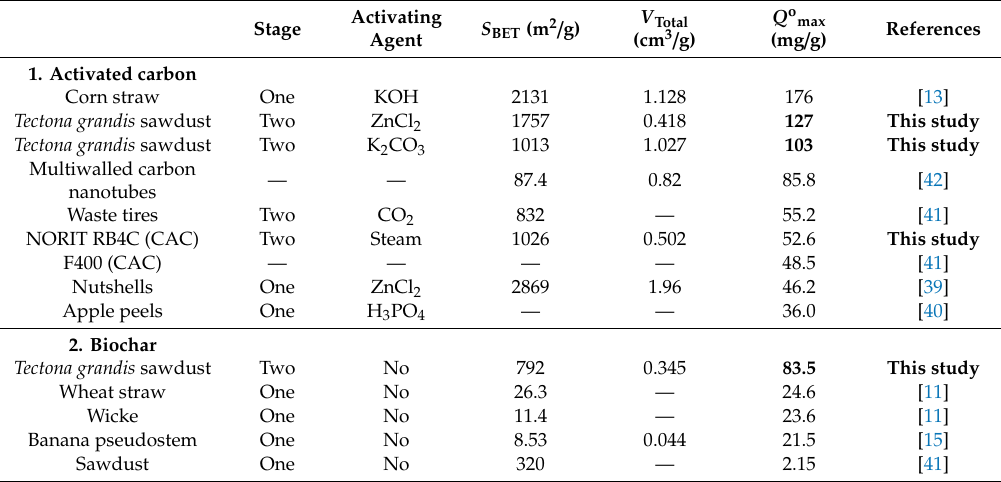
Table 3. Comparison of the maximum adsorption capacity ( Q o max ; mg / g) of the biochar and activated carbon in this study and the other corresponding adsorbents in the literature.